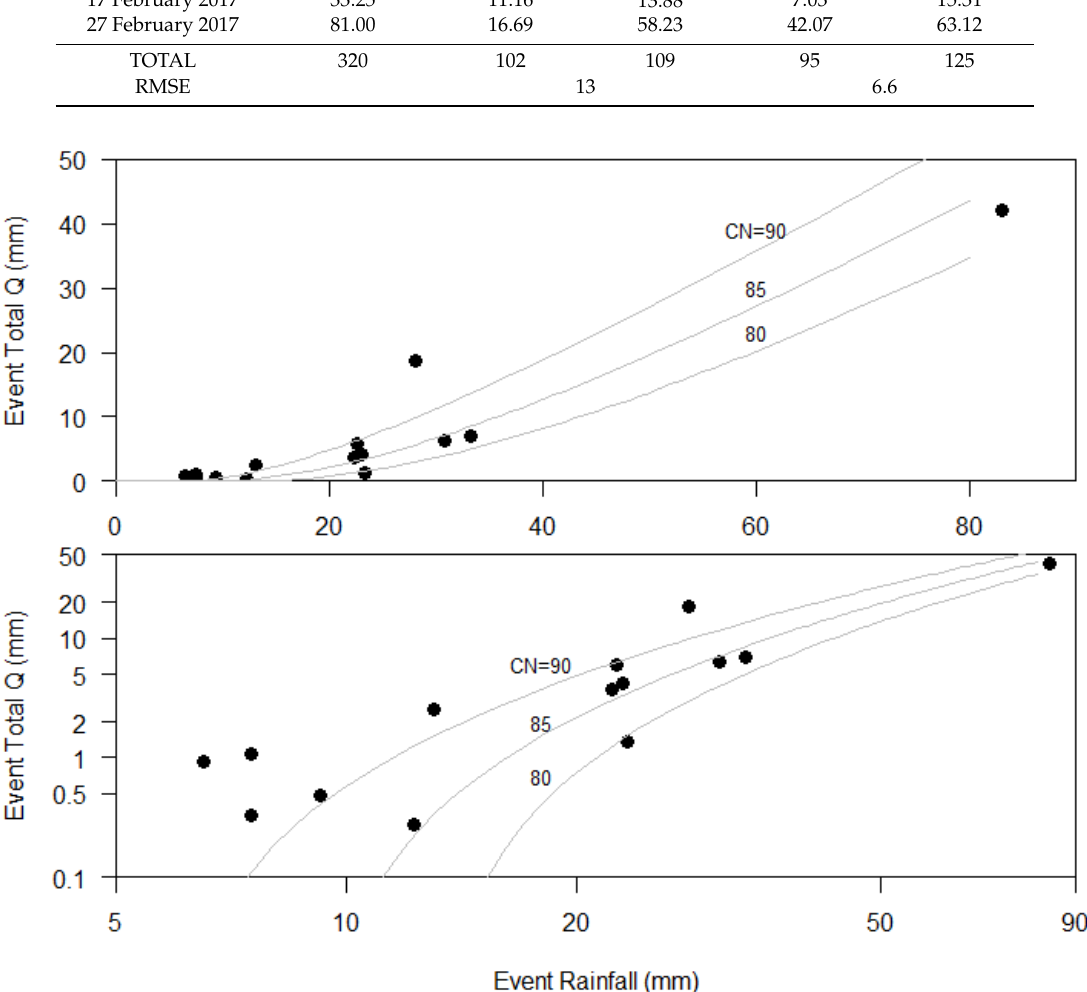
Figure 6. Rainfall-runoff relationship for all observed storm events, with several SCS CN rainfall-runoff relationships, in non-log (top) and log-log (bottom). Taken from Biggs et al. [33].